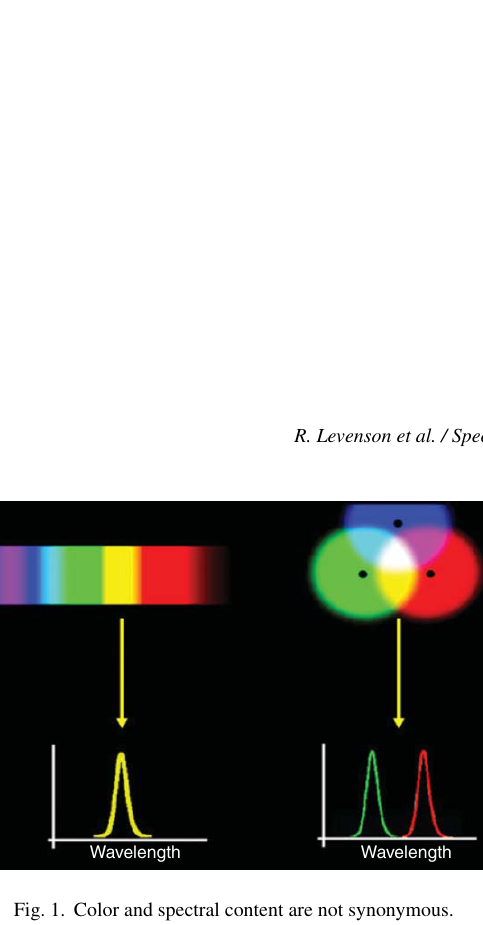
Fig. 1. Color and spectral content are not